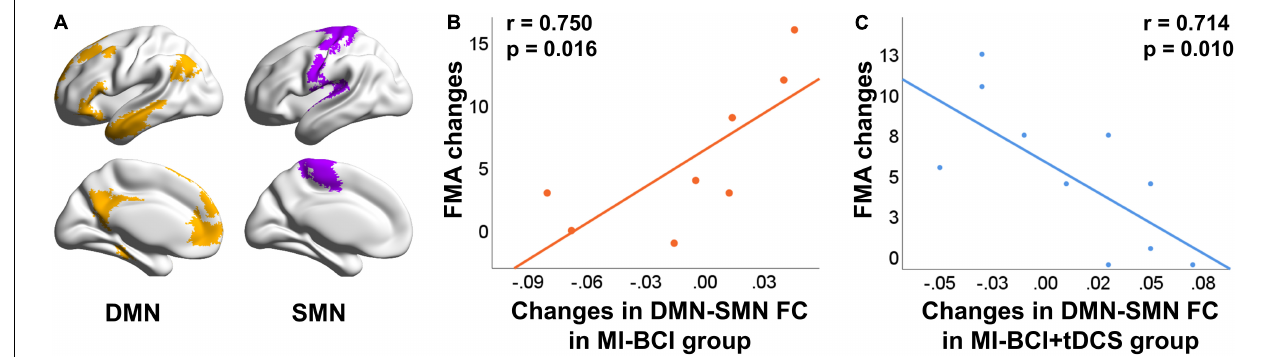
FIGURE 5 | Differential correlation between FC changes and behavioral outcome changes using different intervention methods. (A) Stroke patients showed lower FC at SMN comparing to healthy controls at baseline ( p = 0.030). (B) Correlation between FC changes and FMA changes in MI-BCI group. A positive correlation was observed between FMA changes and interconnectivity changes of DMN and SMN. (C) Correlation between FC changes and FMA changes in MI-BCI + tDCS group. A negative correlation was observed between FMA changes and interconnectivity changes of DMN and